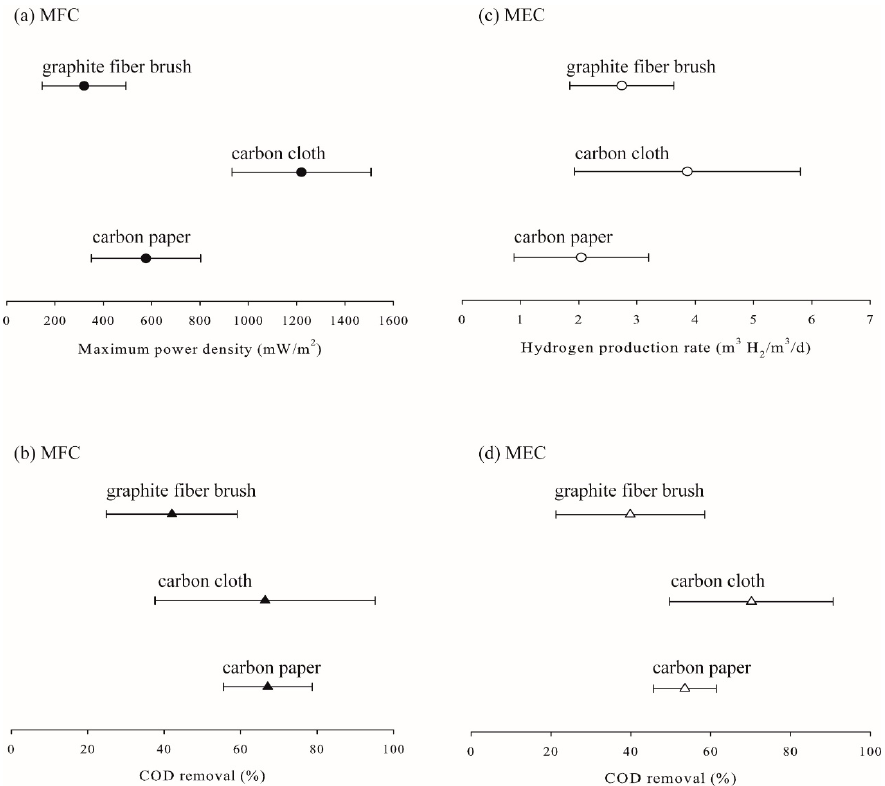
Figure 6. Influences of electrode material on ( a ) MFCs’ power generation, ( b ) MFCs’ COD removal, ( c ) MECs’ hydrogen production, and ( d ) MECs’ COD removal.